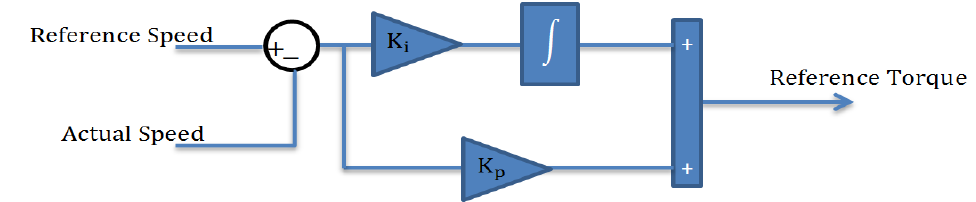
Figure 12. Simulation design of a PI speed regulator.